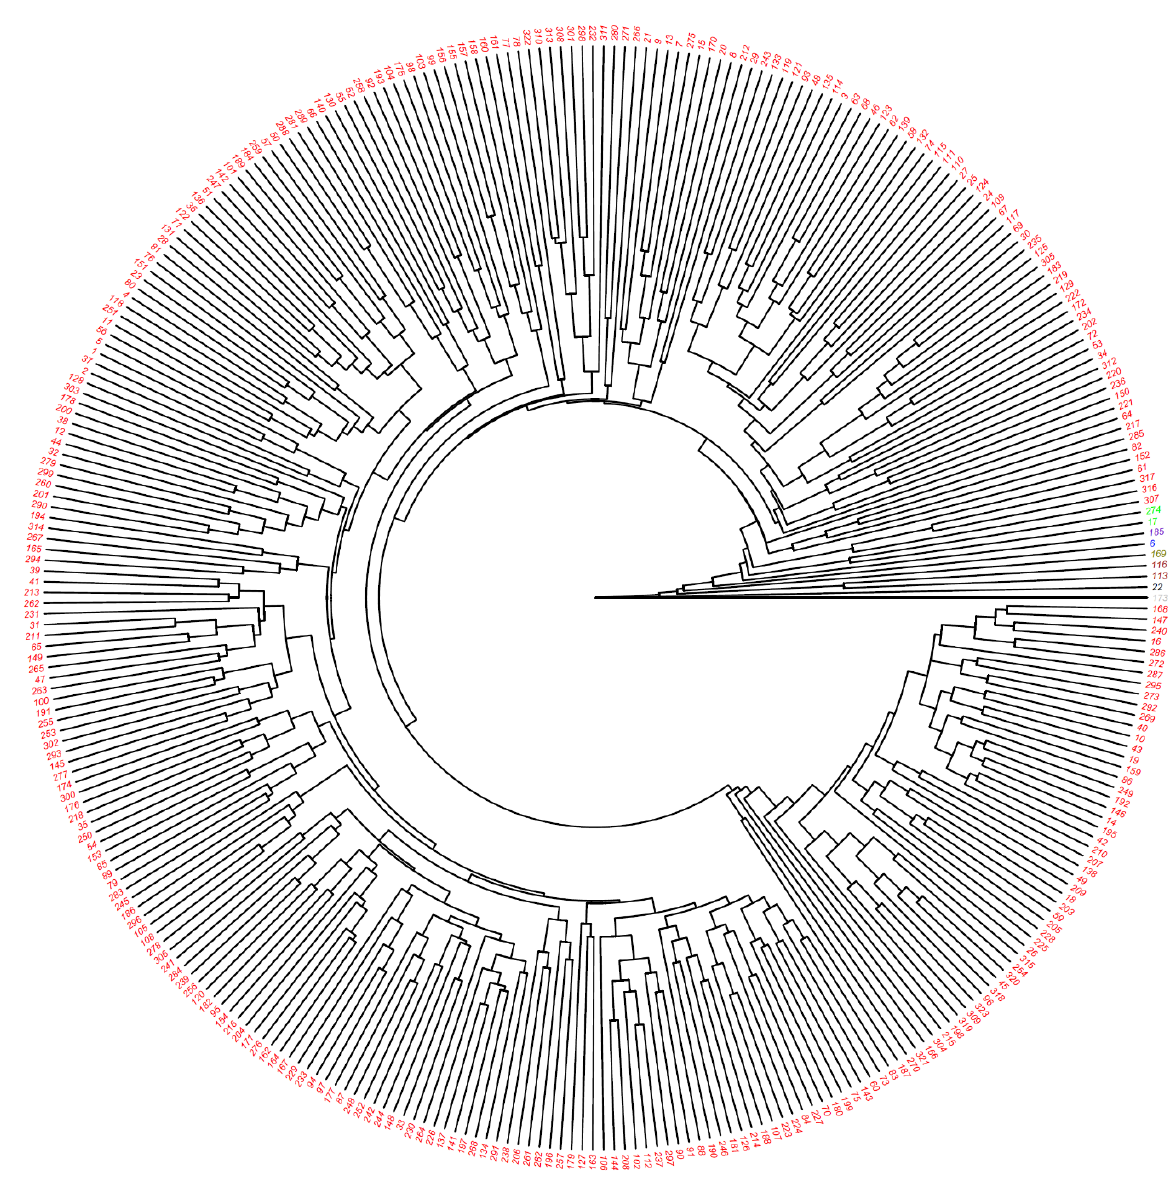
Fig. 1. Grouping of 323 accessions of C. canephora by the UPGMA method, based on the Standardized Average Euclidean Distance matrix and 38 characters evaluated in the Germplasm Active Bank, Experimental Farm